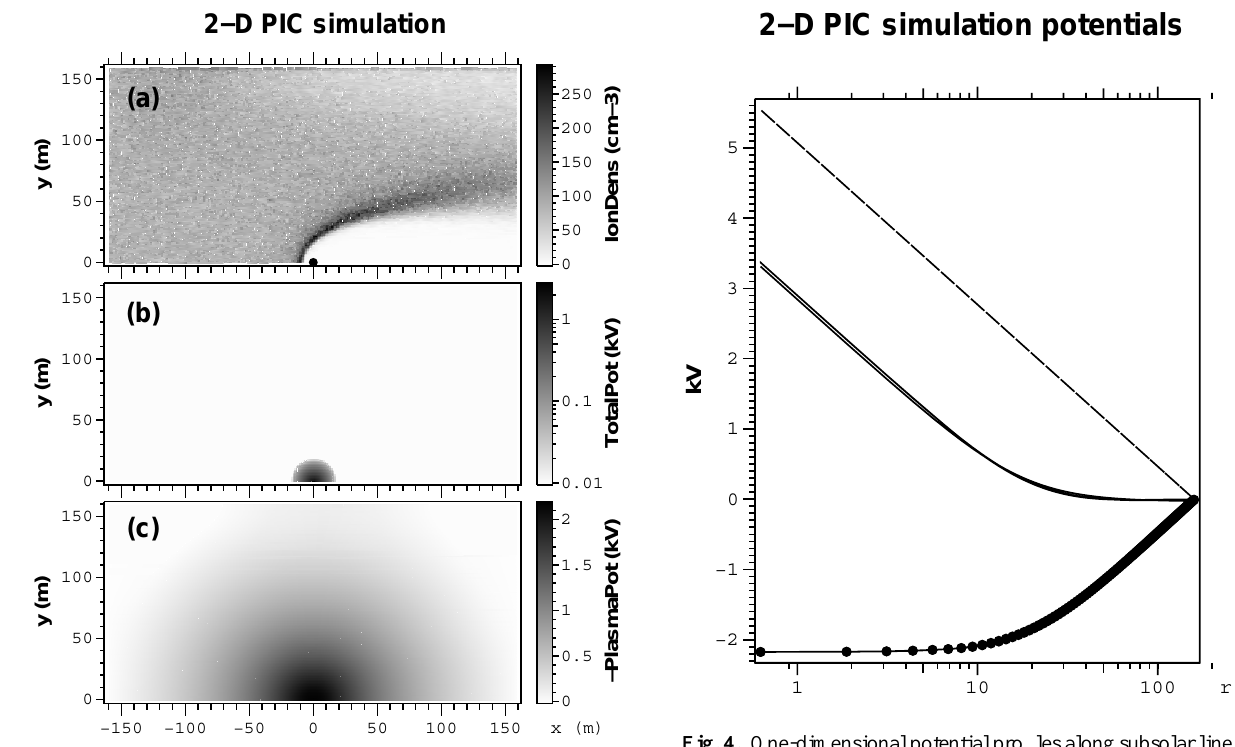
Fig. 3. Saturated state (at t = 20ms) of the baseline 2-D PIC sim- ulation. Instantaneous ion density (a) , potential (b) and negative of the part of the potential which is due to the plasma (c) . Scale is log- arithmic in (b) and linear in (a) and (c). Solar wind arrives from the left and the wire is at (x,y) = ( 0 , 0 ) . Panels (b) and (c) have been time averaged over 0.5ms.